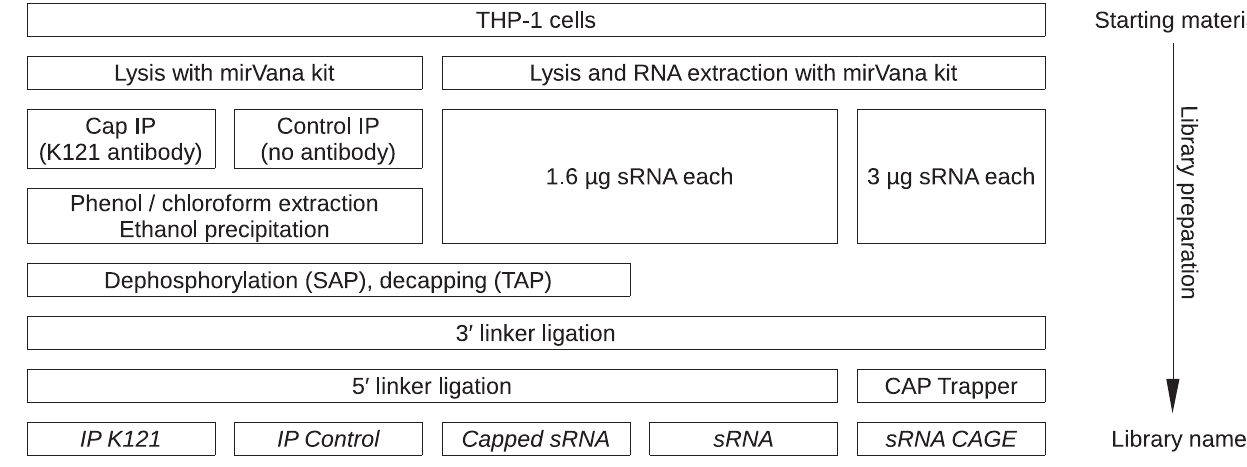
Figure 1. Construction of sequence libraries enriched for capped sRNAs. Step-by-step graphical summary of the construction of the sRNA libraries. The bottom line indicates the library name; in the manuscript, these names are emphasized in italics. The key methods are immunoprecipitation for the IP K121 and IP control libraries, TAP (or mock) treatment for the Capped sRNA and sRNA libraries, and CAP Trapper for the sRNA CAGE libraries.